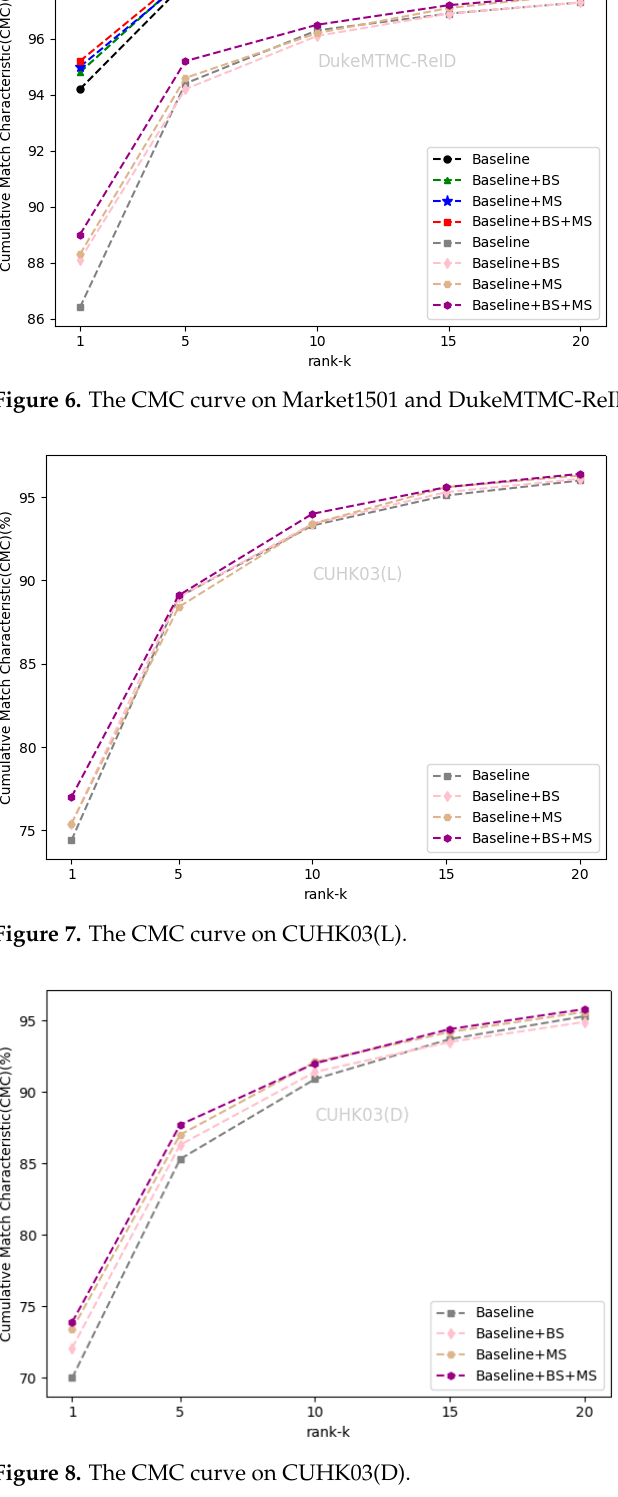
Figure 8. The CMC curve on CUHK03(D).